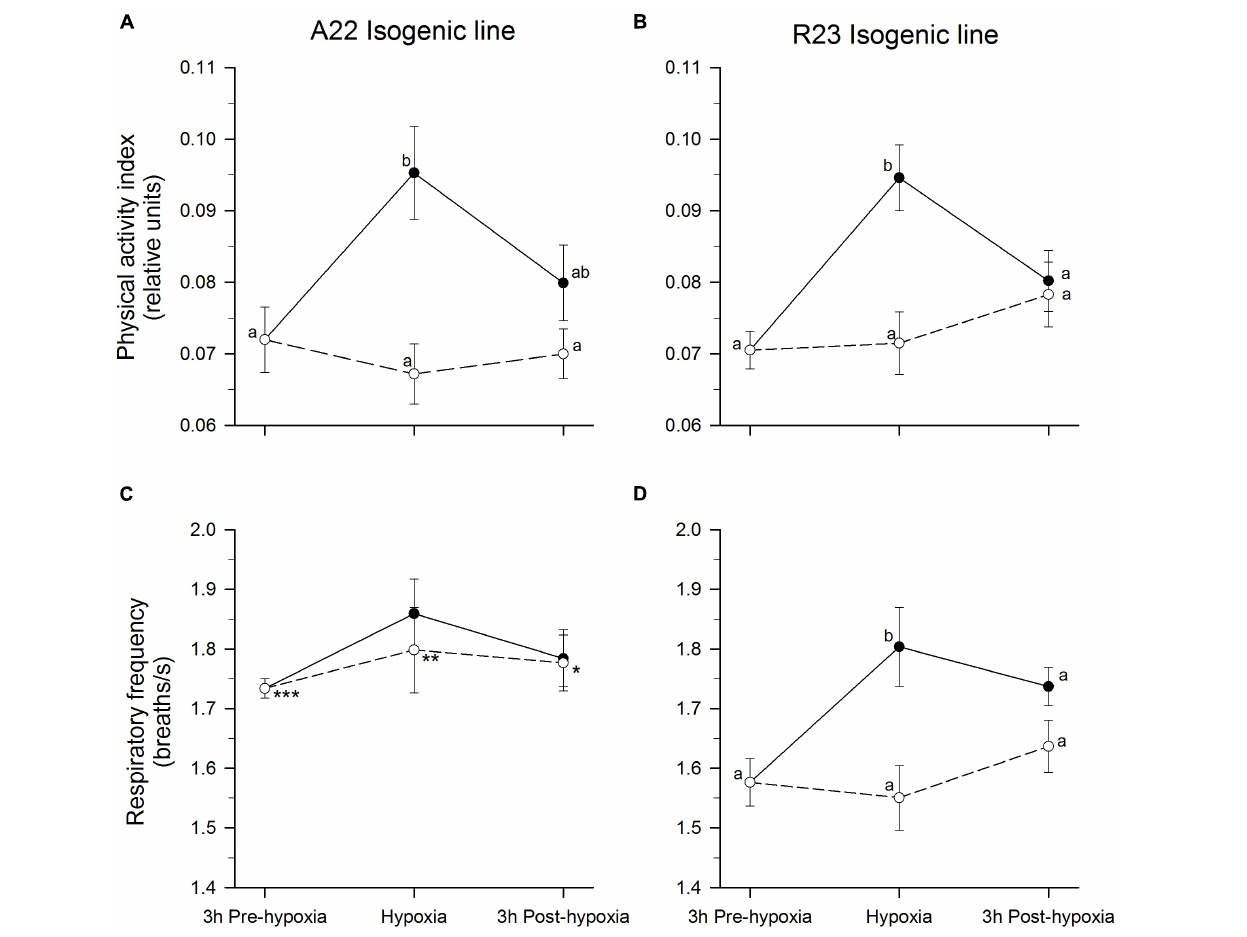
FIGURE 3 | AEFishBIT records of physical activity (A,B) and respiratory frequency (C,D) of rainbow trout isogenic lines A22 (A,C) and R23 (B,D) exposed to a 3 h hypoxia (from 8.0–9.0 ppm to 2.8–3.0 O 2 ppm) challenge. For each individual (598 ± 10 g body weight), measures taken every 15 min are averaged at each time point (3 h pre-challenge, 3 h hypoxia, 3 h post-challenge). Black circles are the values of hypoxia-challenged fish, whereas white circles are those of unchallenged fish. Values are expressed as mean ± SEM ( n = 10 for hypoxia and post-challenge groups, n = 20 for pre-challenge fish). Different letters represent significant ( P < 0.05, ANOVA, SNK test) differences among challenge time points. Asterisks represent significant (* P < 0.05; ** P < 0.01; *** P < 0.001, t -test) between trout lines at the same time point and challenge.